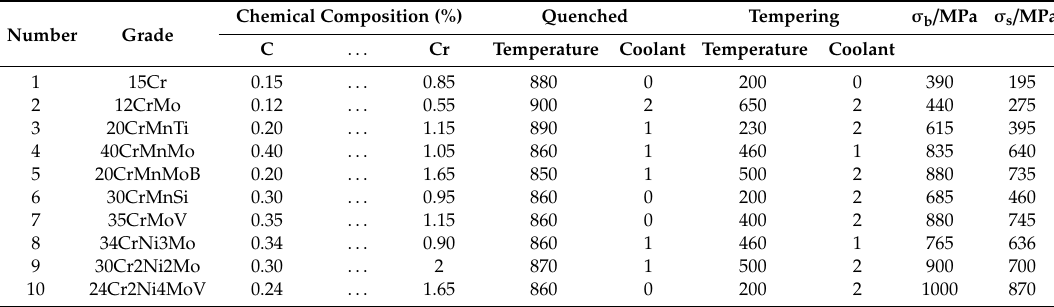
Table 1. Partial data of the American Society of Metals (ASM) Alloy Center